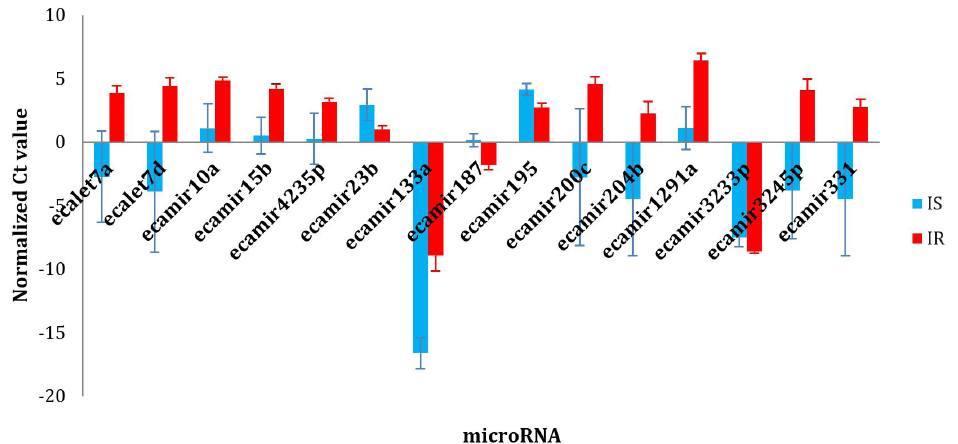
Figure 4. Delta Ct values of significantly different miRNAs between groups: insulin sensitive (IS, n=4) and insulin resistant (IR, n=8) ponies.